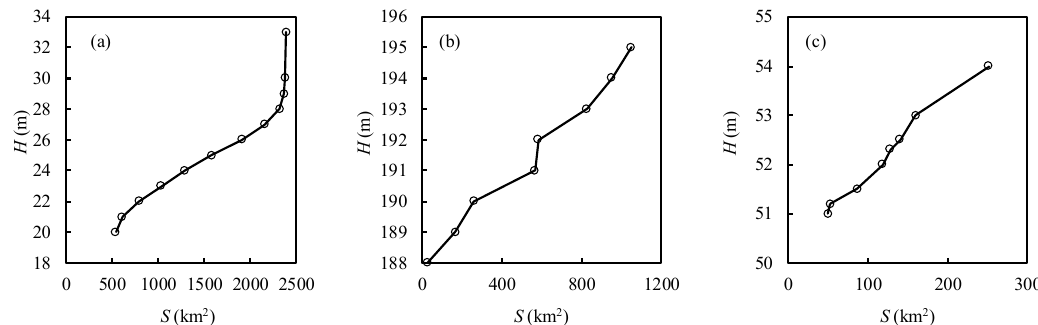
Figure 2. Water level ( H )-lake area ( S ) curves for ( a ) the Dongting Lake [19], ( b ) the Ebinur Lake [4], and ( c ) the Honghe wetland [5].